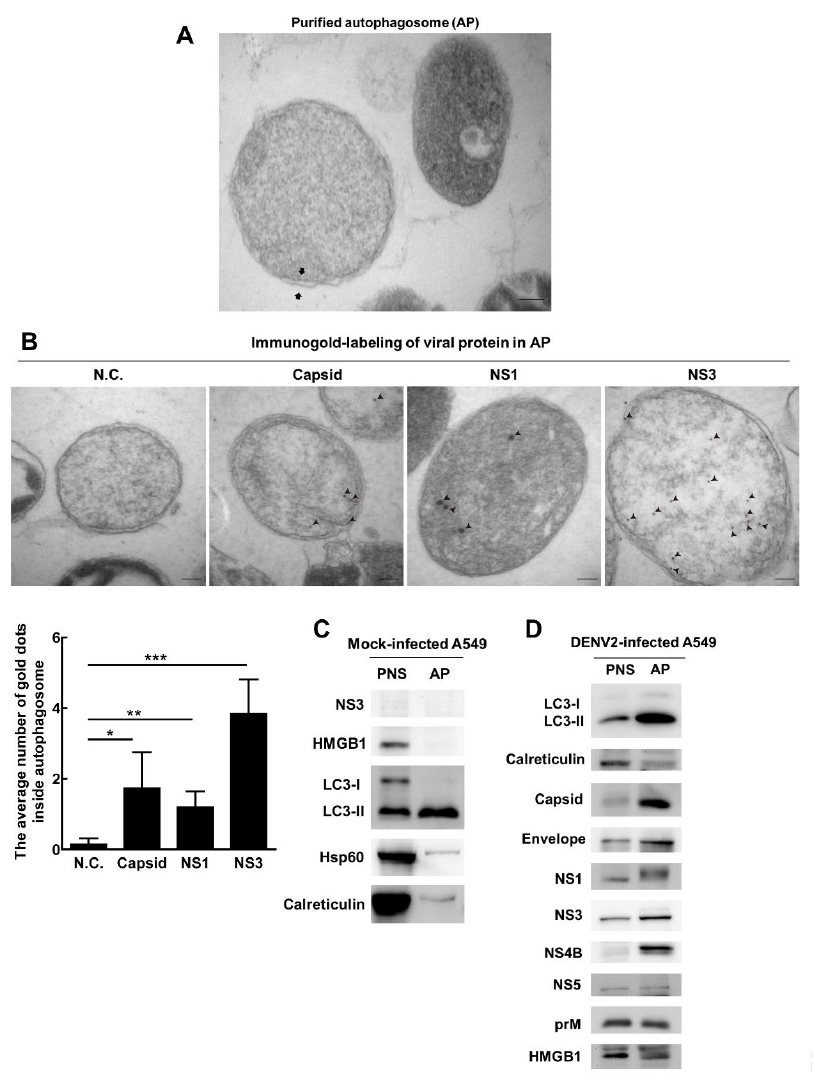
Figure 2. DENV2 capsid, envelope, NS1, NS3 and NS4B proteins are abundantly detected in the purified autophagosomes of infected lung cancer A549 cells. ( A ) Cells were infected with DENV2 (MOI = 10) for 36 h followed by treatment with chloroquine (CQ, 50 μM) for another 24 h to block lysosome fusion and degradation. The autophagosome was purified by sucrose gradient centrifu- gation and observed under TEM. Scale bar = 100 nm. The arrow indicates the double-membrane of the purified autophagosome. ( B ) The protein expression of the capsid, NS1 and NS3 was detected by specific antibodies. Negative control (N.C.) used IgG antibody for immunogold-labeling. Im- muno-gold labeled NS1 (18 nm gold beads), Capsid (12 nm gold beads) and NS3 (12 nm gold beads) in the purified autophagosomes were detected under the TEM. The quantification of gold particles for each protein inside autophagosomes was shown. Scale bar = 100 nm. * p < 0.05, ** p < 0.01, *** p < 0.001. ( C ) Lung cancer cells (A549) without DENV infection and culture for 36 h followed by block- ing autophagosome and lysosome fusion with chloroquine (CQ, 50 μM) for another 24 h. Sucrose gradient centrifugation was conducted to obtain purified AP and PNS. A total of 10 μg protein from